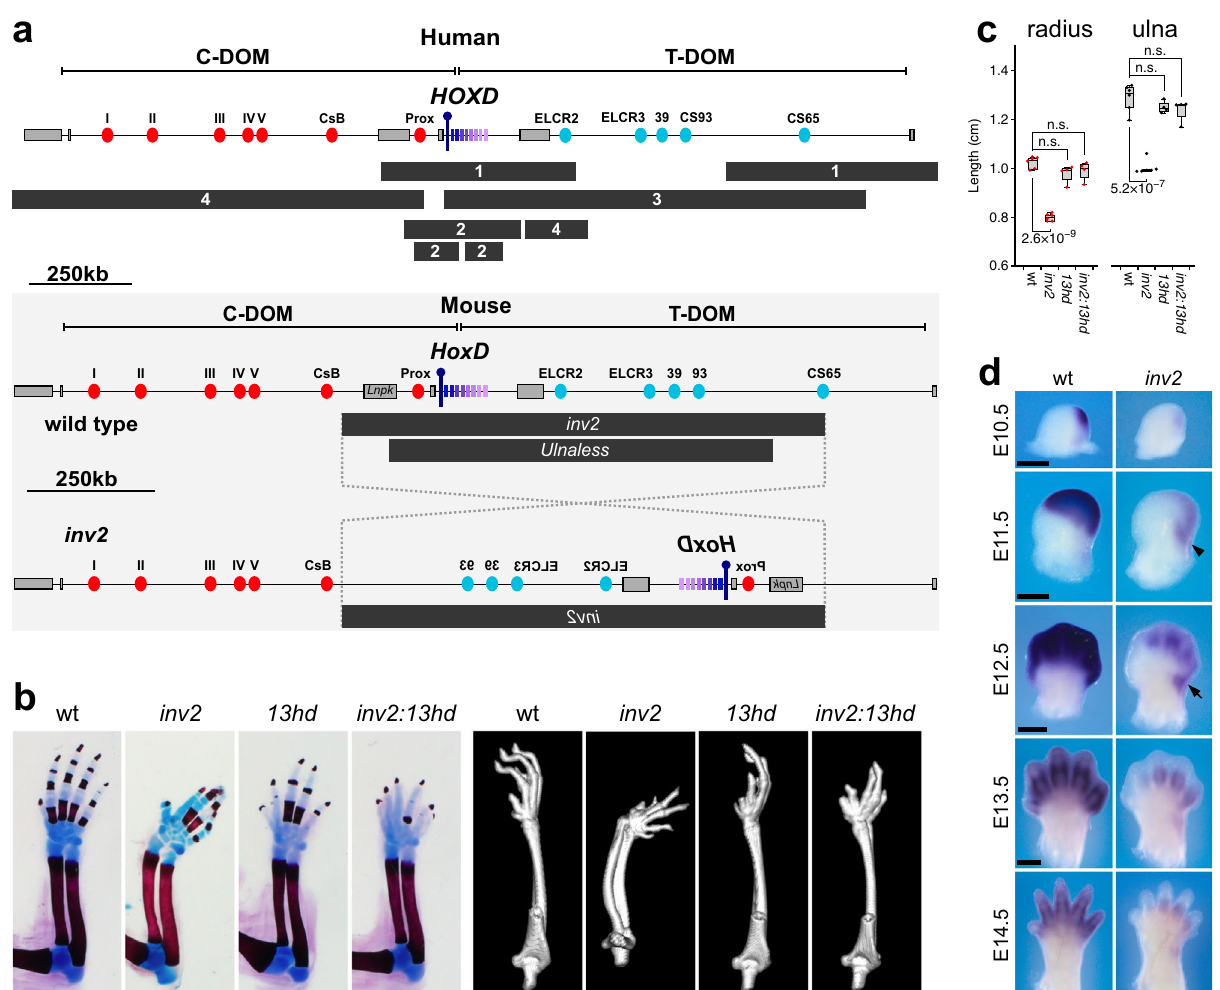
Fig. 1 Inversion of the Hoxd gene cluster induces limb mesomelic dysplasia. a The top panel shows a map of the human HOXD locus with the positions of mapped chromosomal rearrangements (black bars) leading to mesomelic dysplasia. The numbers inside the black bars refer to the original references: (1) Kantaputra et al. (2010) 1 , (2) Le Caignec et al. (2019) 2 , (3) Cho et al. (2010) 3 , (4) Peron et al. (2018) 4 . The panels below (gray box) depict the wild type mouse locus (top) and the structure of the Hoxd inv2 ( inv2 ) inverted allele. In both murine and human loci, the proximal (blue ovals) and distal (red ovals) limb enhancers are indicated, located on either side of the cluster, within the T-DOM and C-DOM TADs, respectively. Hoxd genes are indicated by rectangles with shades of magenta, with a purple pin to indicate the position of Hoxd13 . The location of the mouse inversion allele Ulnaless is indicated below the inv2 allele. b Newborn skeletal stains (left, scale is 1 mm) and adult micro-CT scans (right, scale is 2.5 mm) showing mesomelic dysplasia associated with the inv2 allele. Inactivation of Hoxd13 in cis ( inv2:13hd ) completely rescues the alteration. With the exception of the wild types, the inv2 , 13hd , and inv2:13hd mutants all show digit alterations due to signi fi cant reduction of Hoxd13 transcripts in the distal limb (see also Supplementary Fig. 1 and Supplementary Video 1). c Quanti fi cation of bone length based on CT scans showing that inv2 radius and ulna are signi fi cantly shorter than wild type control bones. The bones of 13hd control mice do not show proximal limb defects. inv2:13hd radius and ulna bones are not different in length to control. Box plots are interquartile range and whiskers indicate maximum and minimum values. P values were determined by two-tailed Welch ’ s unequal variances t -test (see Source Data File for additional details, n = number of limbs measured: wt n = 6, inv2 n = 6, 13hd n = 4, inv2:13hd n = 4), ns not signi fi cant. d Timecourse hybridizations for Hoxd13 mRNAs showing both the decrease of transcripts in distal cells and the ectopic proximal expression domain (arrow), most visible at E11.5 and E12.5. Scale bars are 0.5 mm. All samples are homozygous for the indicated mice, was con fi rmed and further assessed after micro-CT scans of several mutant and control skeletons (Fig. 1b, right panels). CT scans allowed for precise measurements of bone lengths and revealed a signi fi cant shortening (ca. 20%, p < 1e − 6) of both radius and ulna (Fig. 1c). In addition, the digits of inv2 mice were hybridization (WISH) (Fig. 1d). During the earliest phase of abnormal, showing a pattern reminiscent of a partial loss of Hoxd13 expression, we observed a weak staining when compared function of Hoxd13 (Fig. 1b and Supplementary Video 1). with wild type limb buds. Shortly after, by E11.5 when the Therefore, the HoxD inv2 allele produced living homozygous mice with a light yet fully penetrant and signi fi cant limb mesomelic proximal and distal limb domains begin to separate, a clear Hoxd13 signal was apparent in the posterior-distal portion of the dysplasia.